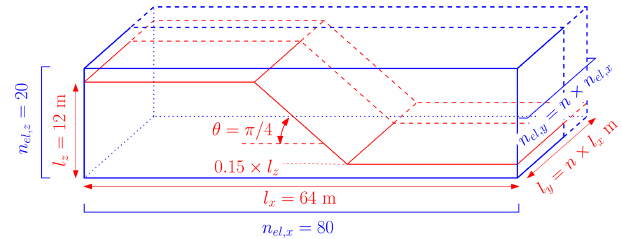
Table 4. Material properties shared by both Models 2a and